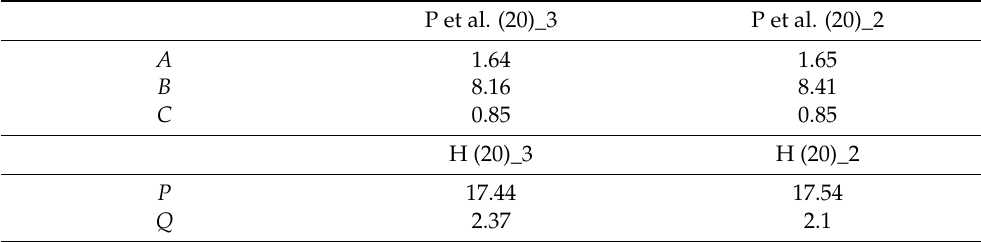
Table 4. Least-square best-fit parameters of Equation (2) and Equation (3) in Loamy Sand.